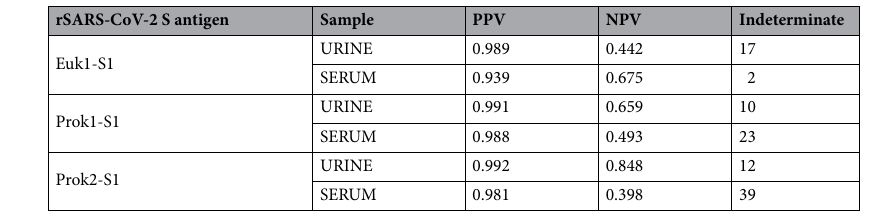
Table 2. Predictive positive and predictive negative values of rSARS-CoV-2 S proteins for urine and serum samples. PPV and NPV were calculated based on the index value, excluding the indeterminate value samples and using the equation: NPV = true negative/false negative + true negative, and PPV = true positive/false positive + true positive.